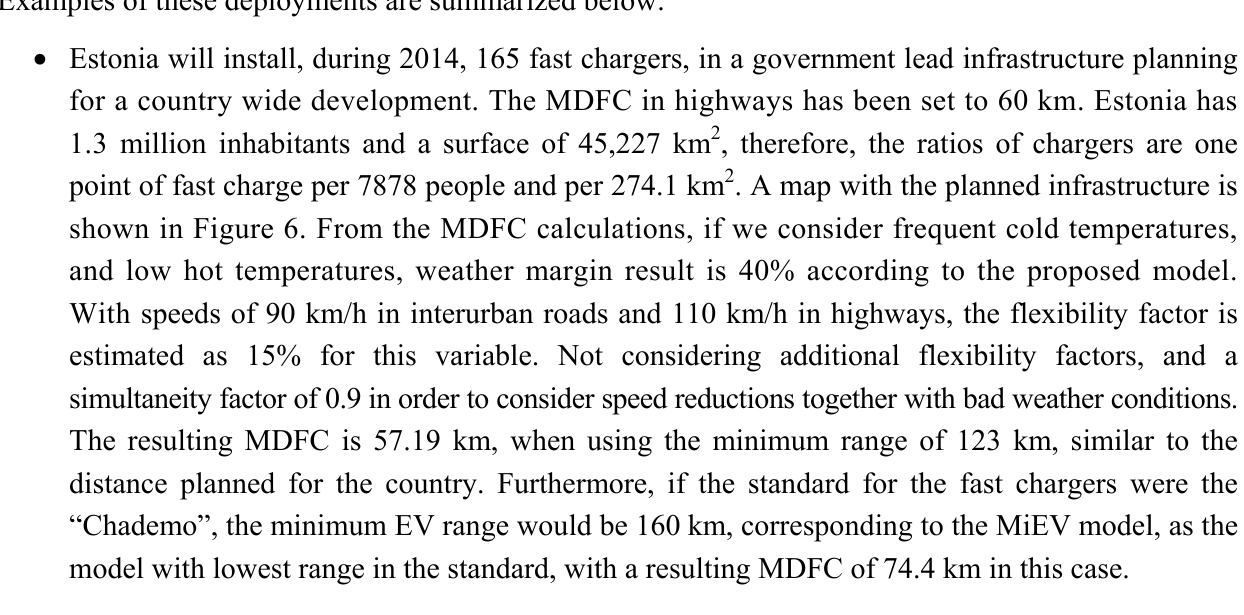
Figure 6. Estonian fast charging infrastructure